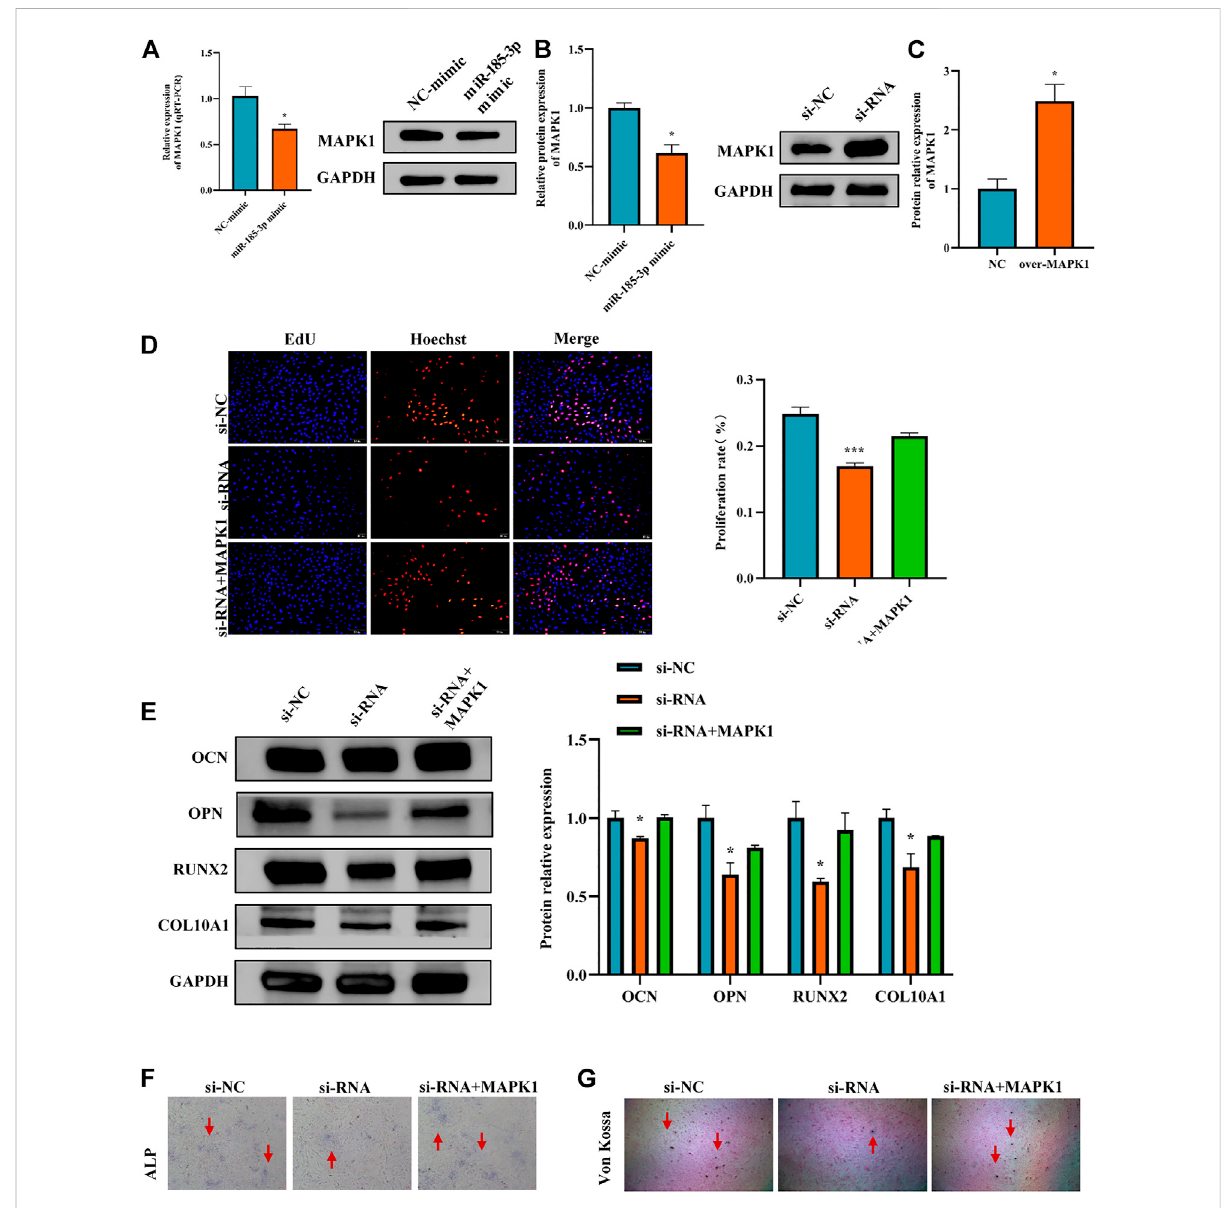
FIGURE 7 Hsa_circ_0008870 suppressed chondrocyte proliferation,hypertrophy and endochondral ossi fi cation by regulating miR-185-3p/MAPK1. (A,B) The mRNA and protein expression of MAPK1 was assessed with miR-185-3p mimics. (C) The protein expression of MAPK1 expression levels was assessed following overexpressing MAPK1. (D) The effect of MAPK1 overexpression on hsa_circ_0008870 knockdown-mediated cell proliferation was measured by Edu assays. (E) The protein expressions of OCN, OPN, RUNX2 and collagen type X were analyzed by Western blot. (F,G) The effect of MAPK1 overexpression on hsa_circ_0008870 knockdown-mediated ALP activity and Von Kossa staining. *, p < 0.05 and ***, p <